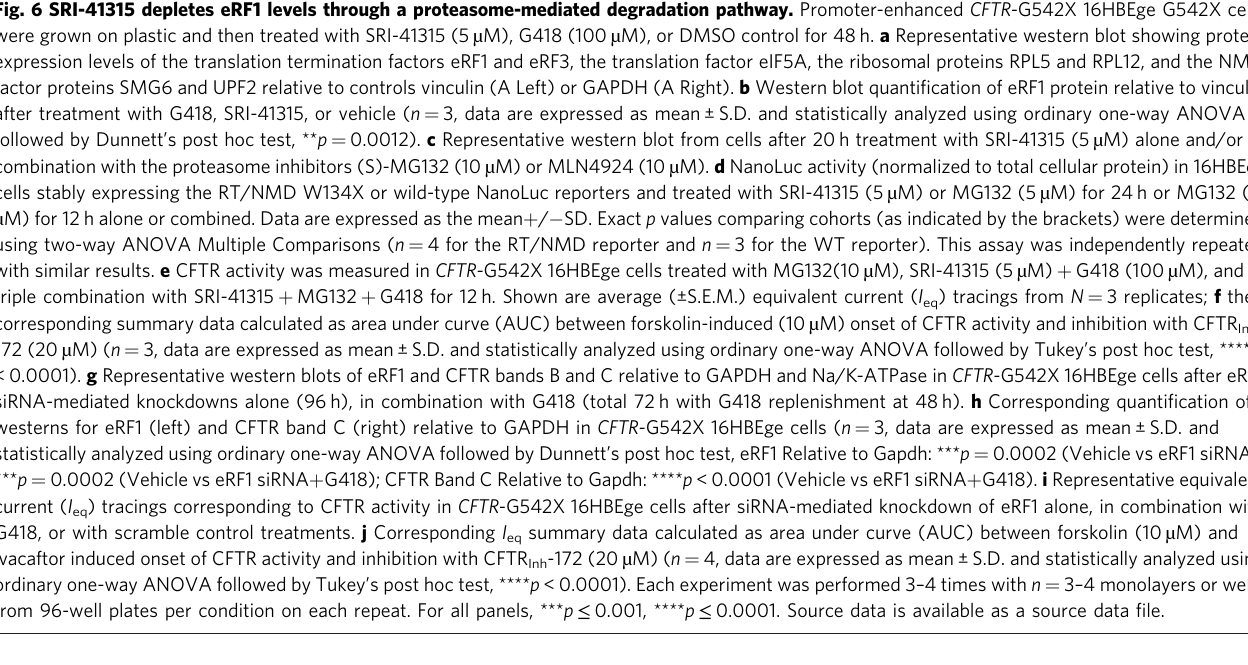
Fig. 6 SRI-41315 depletes eRF1 levels through a proteasome-mediated degradation pathway. Promoter-enhanced CFTR -G542X 16HBEge G542X cells were grown on plastic and then treated with SRI-41315 (5 µ M), G418 (100 µ M), or DMSO control for 48 h. a Representative western blot showing protein expression levels of the translation termination factors eRF1 and eRF3, the translation factor eIF5A, the ribosomal proteins RPL5 and RPL12, and the NMD factor proteins SMG6 and UPF2 relative to controls vinculin (A Left) or GAPDH (A Right). b Western blot quanti fi cation of eRF1 protein relative to vinculin after treatment with G418, SRI-41315, or vehicle ( n = 3, data are expressed as mean ± S.D. and statistically analyzed using ordinary one-way ANOVA followed by Dunnett ’ s post hoc test, ** p = 0.0012). c Representative western blot from cells after 20 h treatment with SRI-41315 (5 µ M) alone and/or in combination with the proteasome inhibitors (S)-MG132 (10 µ M) or MLN4924 (10 µ M). d NanoLuc activity (normalized to total cellular protein) in 16HBE σ - cells stably expressing the RT/NMD W134X or wild-type NanoLuc reporters and treated with SRI-41315 (5 µ M) or MG132 (5 µ M) for 24 h or MG132 (5 µ M) for 12 h alone or combined. Data are expressed as the mean + / − SD. Exact p values comparing cohorts (as indicated by the brackets) were determined using two-way ANOVA Multiple Comparisons ( n = 4 for the RT/NMD reporter and n = 3 for the WT reporter). This assay was independently repeated with similar results. e CFTR activity was measured in CFTR -G542X 16HBEge cells treated with MG132(10 µ M), SRI-41315 (5 µ M) + G418 (100 µ M), and in triple combination with SRI-41315 + MG132 + G418 for 12 h. Shown are average (±S.E.M.) equivalent current ( I eq ) tracings from N = 3 replicates; f the corresponding summary data calculated as area under curve (AUC) between forskolin-induced (10 µ M) onset of CFTR activity and inhibition with CFTR Inh - 172 (20 µ M) ( n = 3, data are expressed as mean ± S.D. and statistically analyzed using ordinary one-way ANOVA followed by Tukey ’ s post hoc test, **** p < 0.0001). g Representative western blots of eRF1 and CFTR bands B and C relative to GAPDH and Na/K-ATPase in CFTR -G542X 16HBEge cells after eRF1 westerns for eRF1 (left) and CFTR band C (right) relative to GAPDH in CFTR -G542X 16HBEge cells ( n = 3, data are expressed as mean ± S.D.